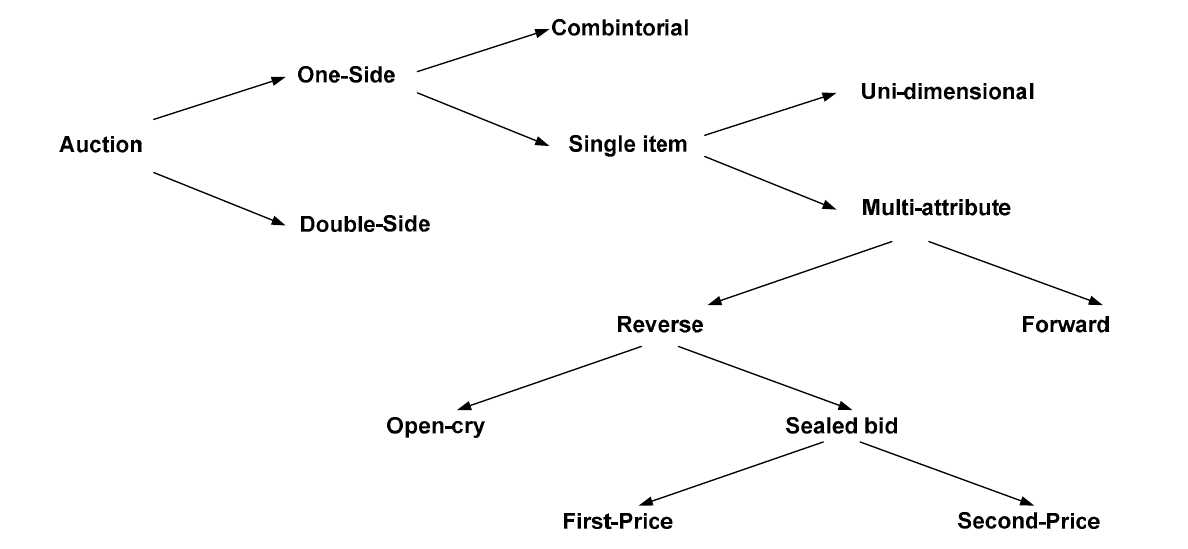
Figure 1. Auction classification according to bidding sides, sold resources, bid composition, and the role of the participants.